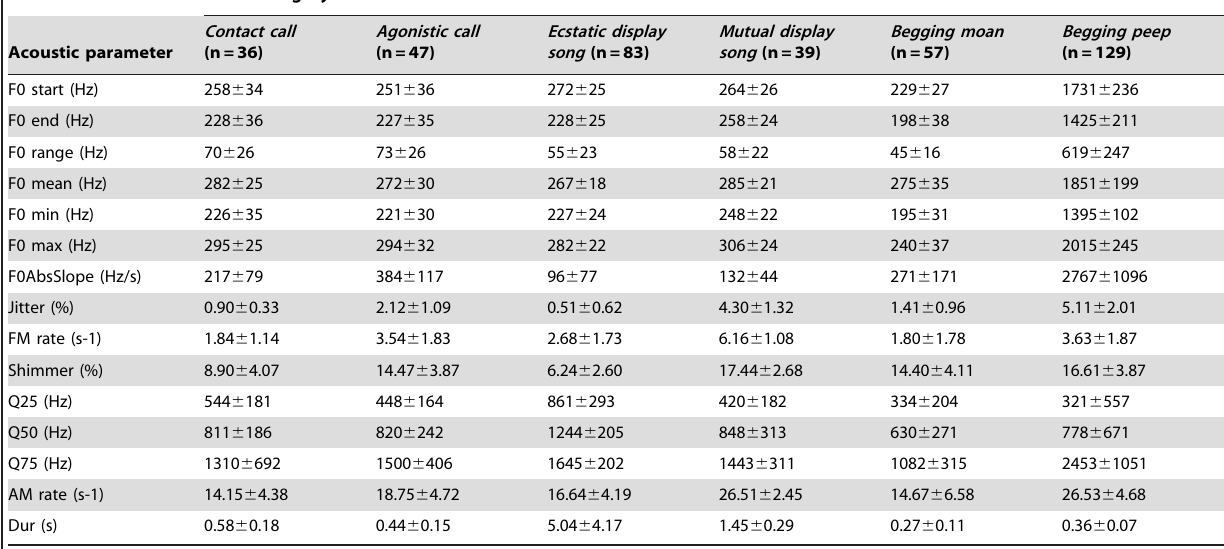
Table shows mean values 6 standard deviation.